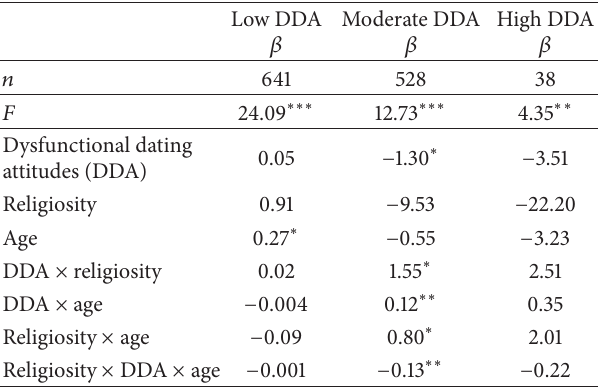
Table 3: Regressions examining the associations between dysfunc- tional dating attitudes, religiosity, age, and youth substance